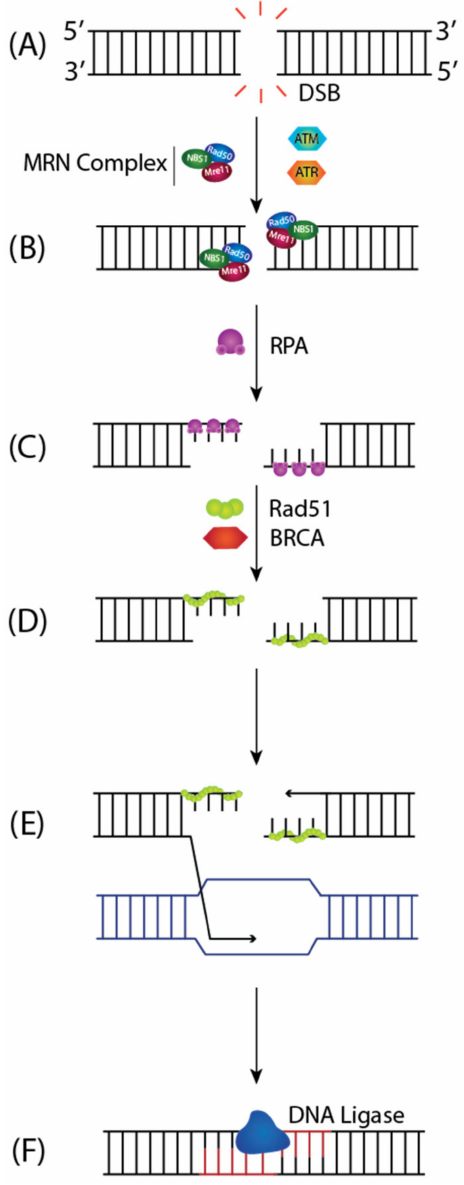
Figure 8. Homologous Recombination (HR) Repair of DSBs. ( A ) HR begins with the 5 (cid:48) -3 (cid:48) extensive resection of break ends by MRN complex to ( B ) generate 3 (cid:48) ssDNA overhangs that are coated with RPA. Once the DNA ends are captured, ATM and ATR kinases trigger downstream signaling to facilitate DNA repair through HR. ( C ) Rad51 is then loaded onto the ssDNA in a BRCA-dependent manner, replacing RPA and forming a nucleoprotein filament, which ( D ) initiates the homology search for complementary sequences. ( E ) This prompts DNA strand invasion, where the 3 (cid:48) end of the invading strand primes DNA synthesis off the sister chromatid. ( F ) After DNA synthesis extends past the DSB, it is precisely